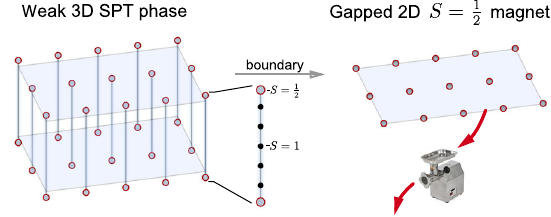
FIG. 1. A 3D system of integer spins can enter a weak SPT phase equivalent to stacking together 1D AKLT chains (as indicated on the left). The weak SPT phase is characterized ∈ by a particular element of the cohomology class Ω weak H 4 ½ Z 3 ; U ð 1 Þ(cid:3) . Since each AKLT chain has degen- × SO ð 3 Þ trans int erate emergent S ¼ 1 = 2 edge states, the effective Hilbert space of the 2D surface of the 3D SPT phase behaves like a S ¼ 1 = 2 magnet: it will have a projective (half-integral) representation of SO(3) in each unit cell. Thus, studying surface phases of the 3D weak SPT is equivalent to studying a 2D S ¼ 1 = 2 magnet. Given a proposal for the braiding, statistics, and symmetry fractionali- zation of the 2D magnet, there is a procedure to calculate an ; U ð 1 Þ(cid:3) , associated obstruction class O ∈ H 4 ½ Z 2 × SO ð 3 Þ trans int with defining an effective theory of the symmetry defects. The bulk-boundary correspondence requires O of the boundary and Ω of the bulk to be compatible, constraining the allowed 2D weak SET